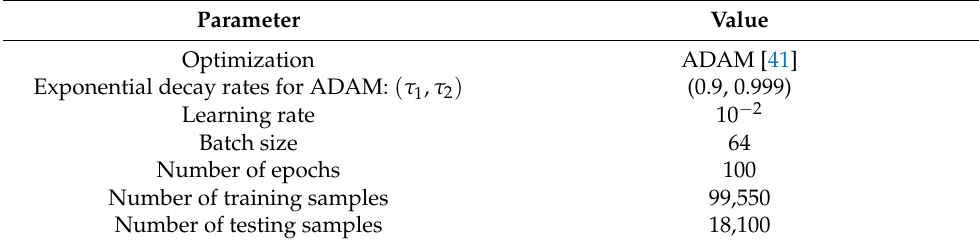
Table 4. Parameters for the